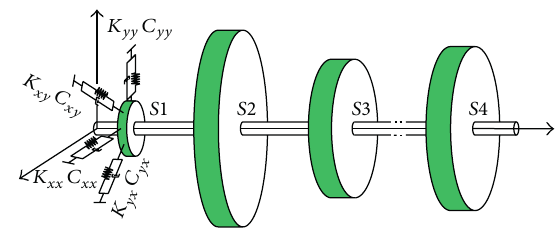
Figure 1: Multidegree rotor bearing